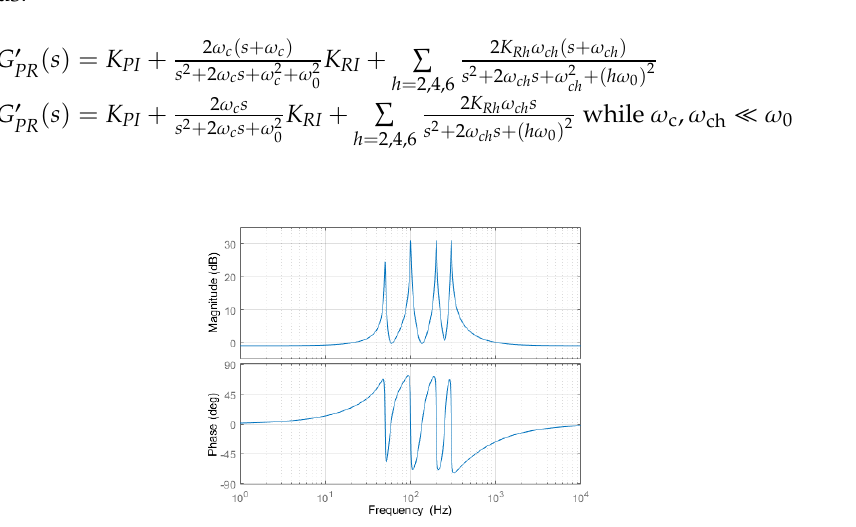
Figure 9. Trajectories sensitivity of notch filter parameters: ( a ) Active power sensitivity; ( b ) Reactive power sensitivity; ( c ) DC bus voltage sensitivity; ( d ) Phase A voltage sensitivity; ( e ) Phase A current sensitivity;